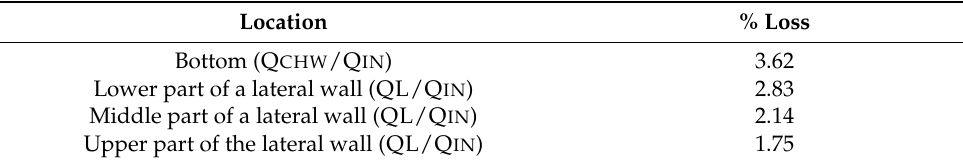
Table 2. Heat-flux